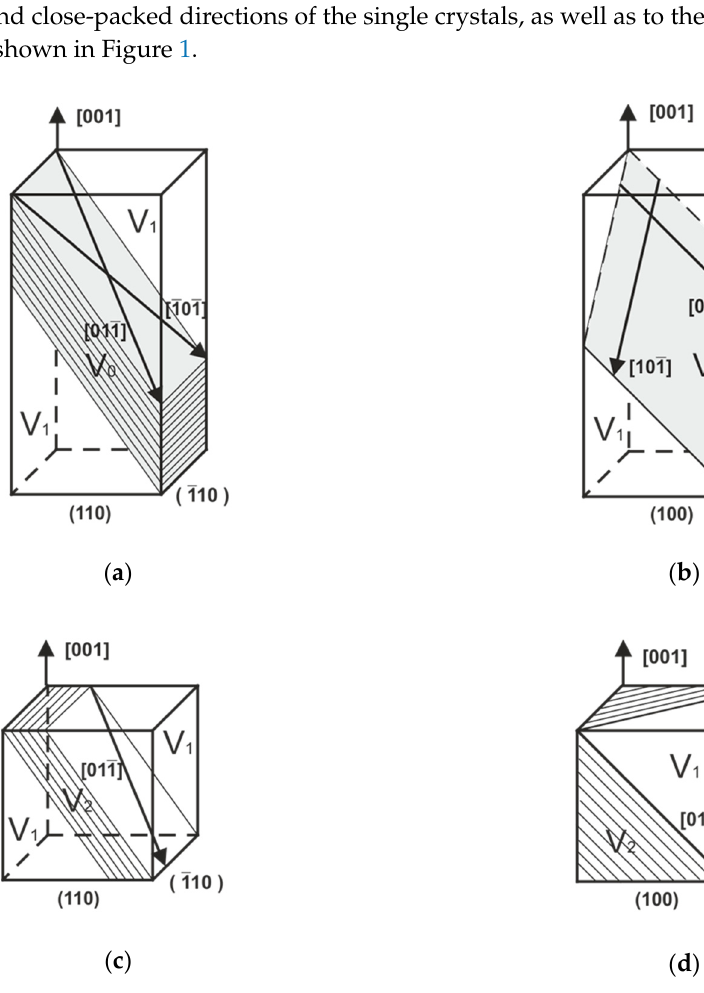
Figure 1. Schematic showing orientations of octahedral plane families in [001] single crystals with h / d = 2; ( c , d ) h / d = 1 and ( a , c ) {110} or ( b , d ) {100} lateral ( a , b ) h/d =2; ( c , d ) h/d =1 and ( a , c ) {110} or ( b , d ) {100} lateral faces.